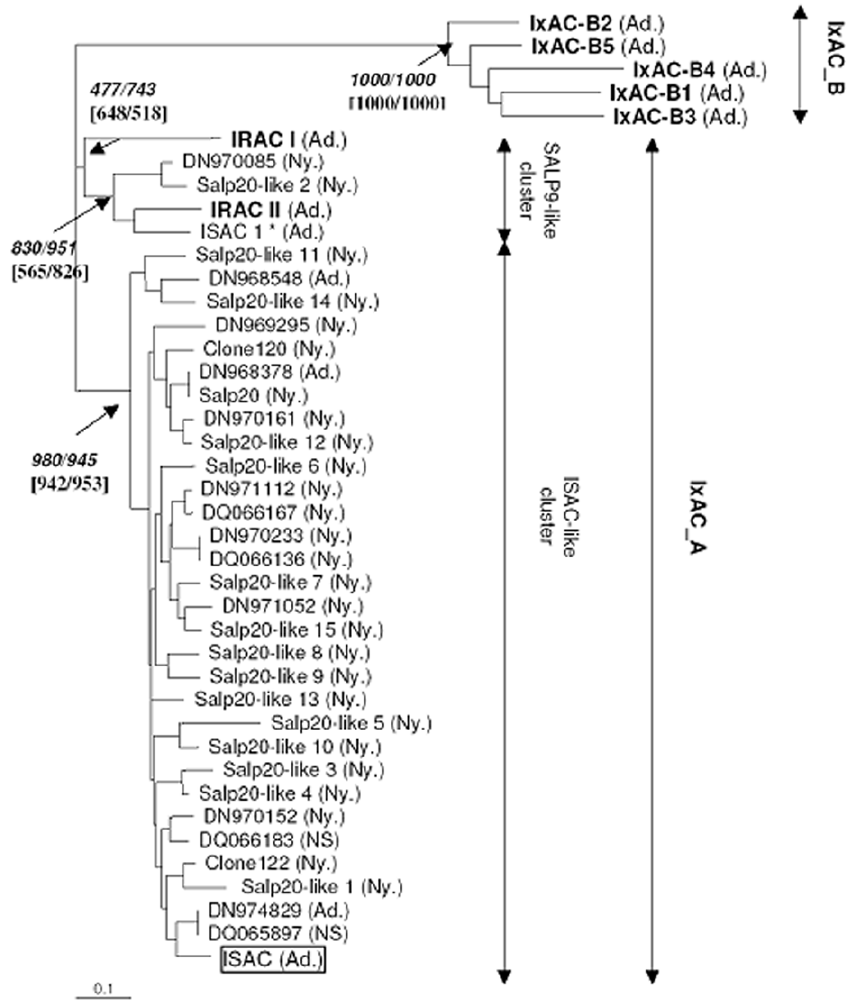
Figure 1. Phylogenetic analysis of Ixodesanticomplement proteins . A distance dendrogram was constructed from an alignment of 41 tick mature anticomplement proteins using programs in the Phylip 3.65 package (see text). Branch length is proportional to distances between peptide sequences. The bootstrap values are indicated near major nodes, calculated from 1000 replicates of the peptide and nucleotide sequence alignments, respectively. Bold characters: I. ricinus entries; *: I. pacificus sequence; all others are from I. scapularis . Prototypical ISAC is boxed. Sequences are identified by their accession number in databases or by descriptive names when available. Ad., isolated from adults; Ny., isolated from nymphs; NS, not